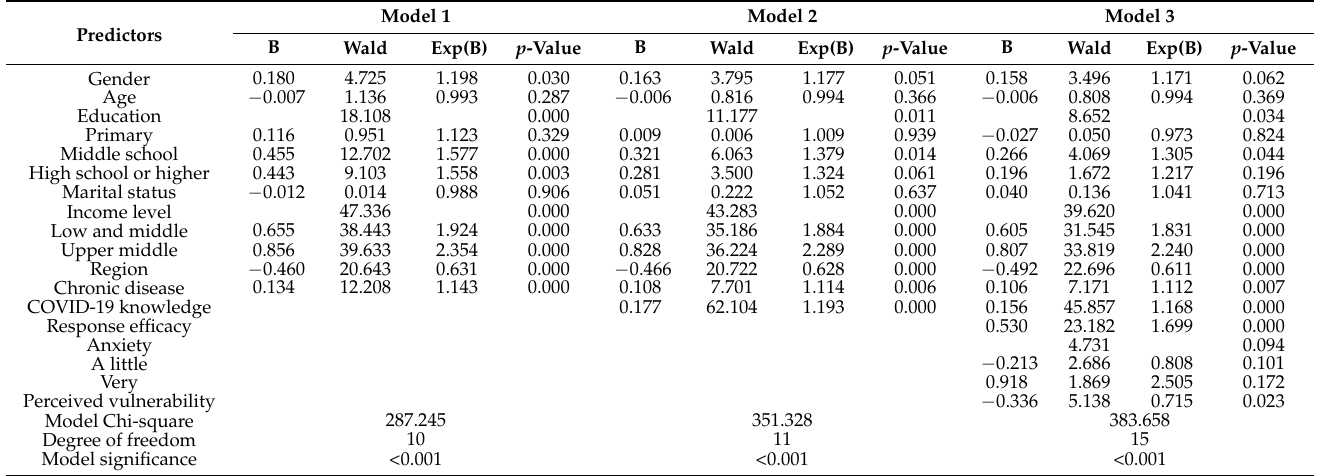
Table 4. Hierarchical logistic regression results on factors related to mask